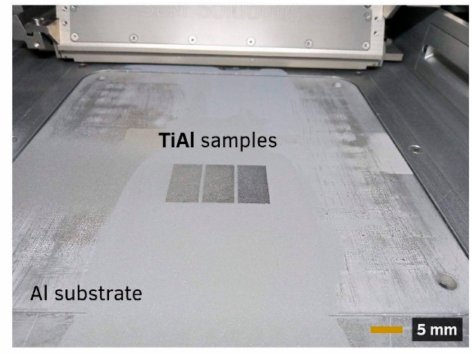
Figure 2. TiAl-based printed plates on the Al